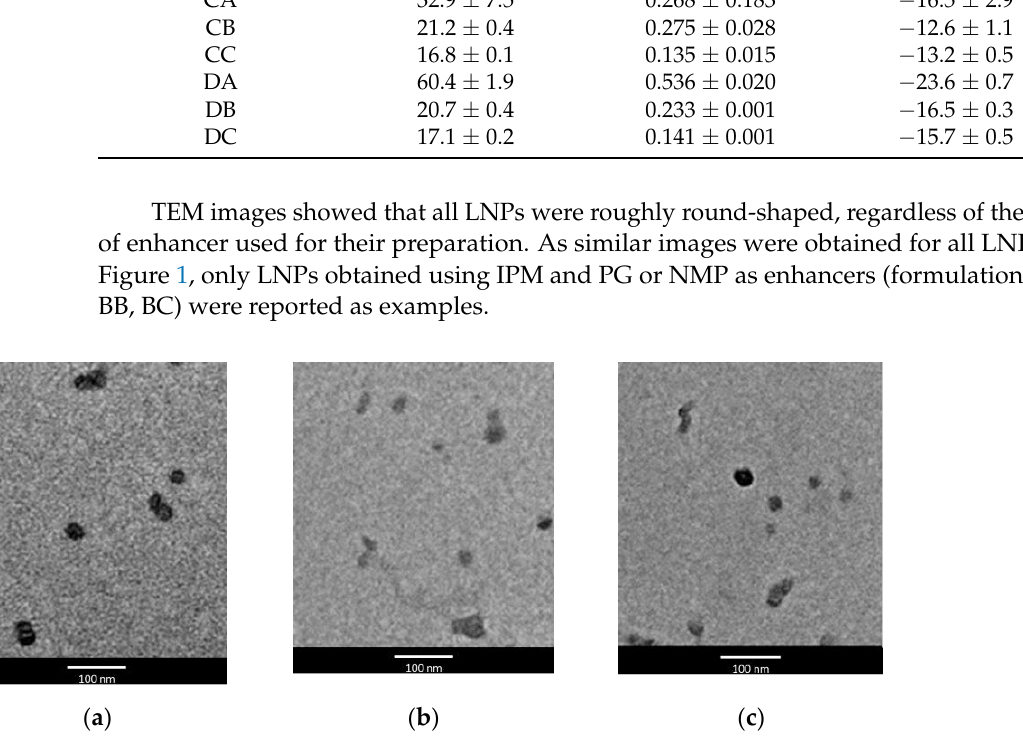
Figure 1. Transmission electron microscopy (TEM) images of idebenone-loaded lipid nanoparticles containing ( a ) isopropyl myristate 3.5% w / w (formulation BA), ( b ) isopropyl myristate 3.5% w / w and 10% w / w N -methylpyrrolidone (formulation BB) and ( c ) isopropyl myristate 3.5% w / w and 10% w / w propylene glycol (formulation BC).